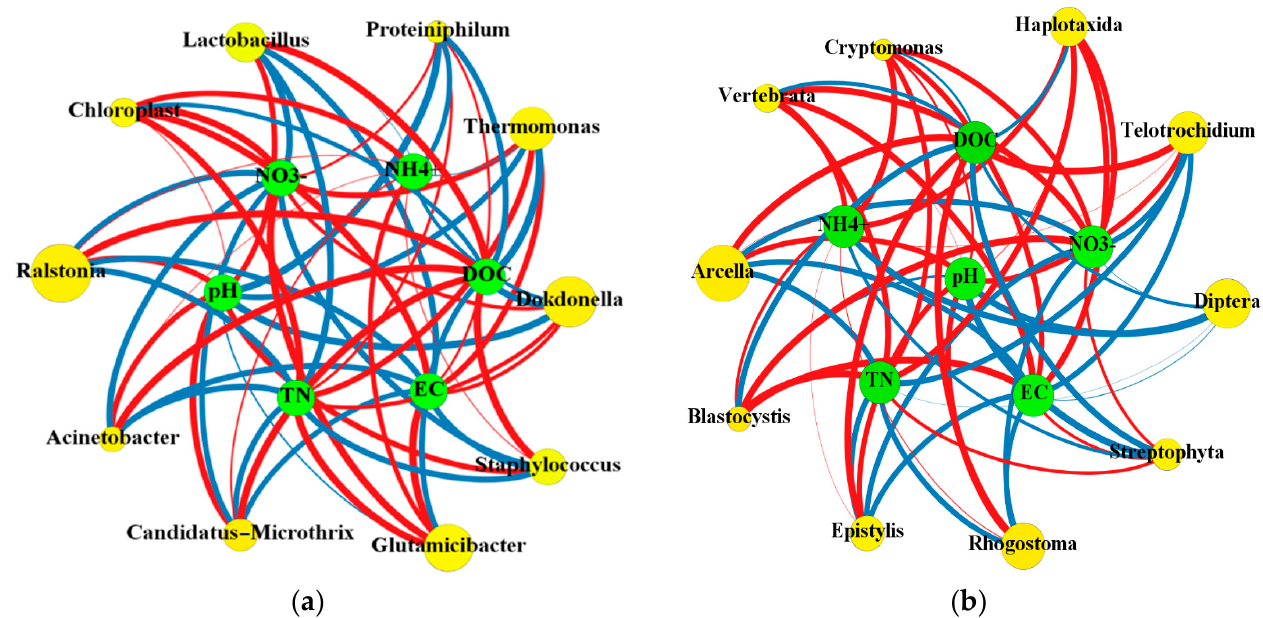
Figure 6. Network diagram showing the relationship between environmental factors and bacterial genus ( a ) or eukaryotic genus; ( b ) dominant in vermicomposting systems. The size of the yellow circle denotes microbial abundance. The thickness of the line indicates the correlation between environmental factors and microorganisms. Table 2. Correlation coefficient among bacterial genus, eukaryotic genus, and physicochemical properties of sludge vermicompost.